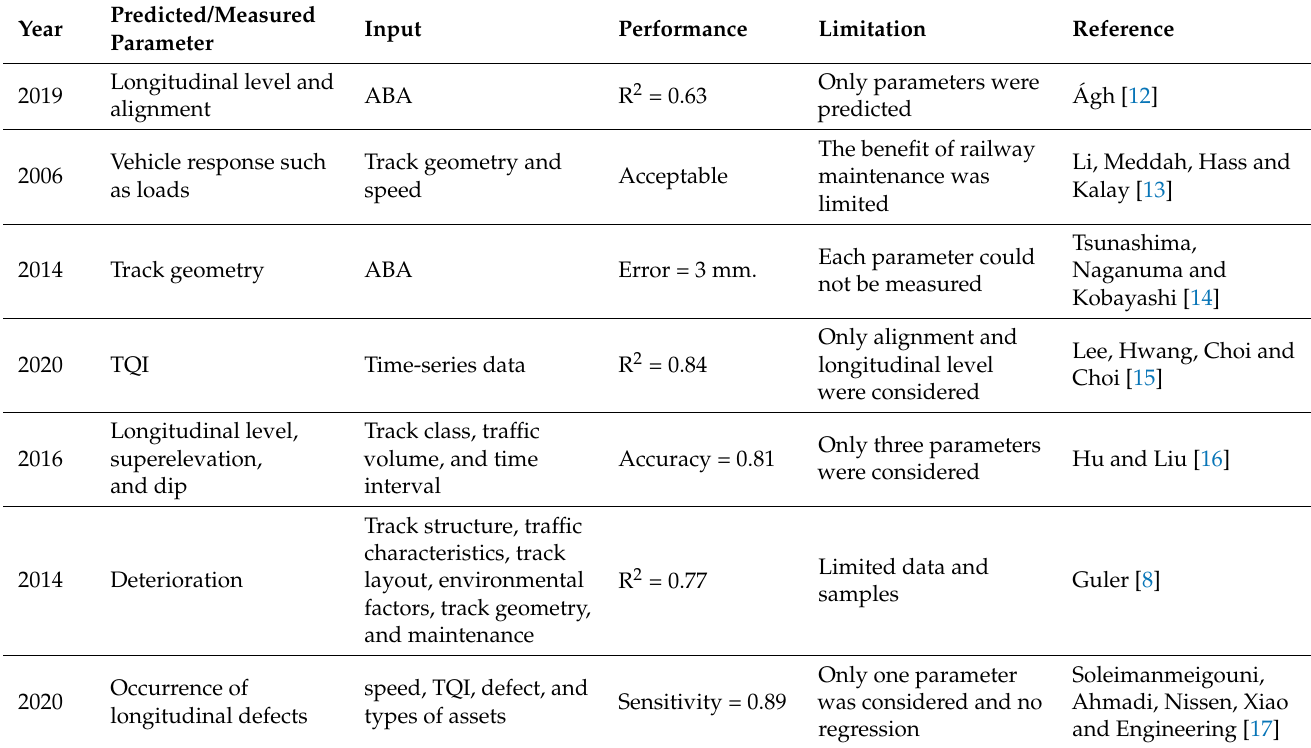
Table 3. Summary of previous